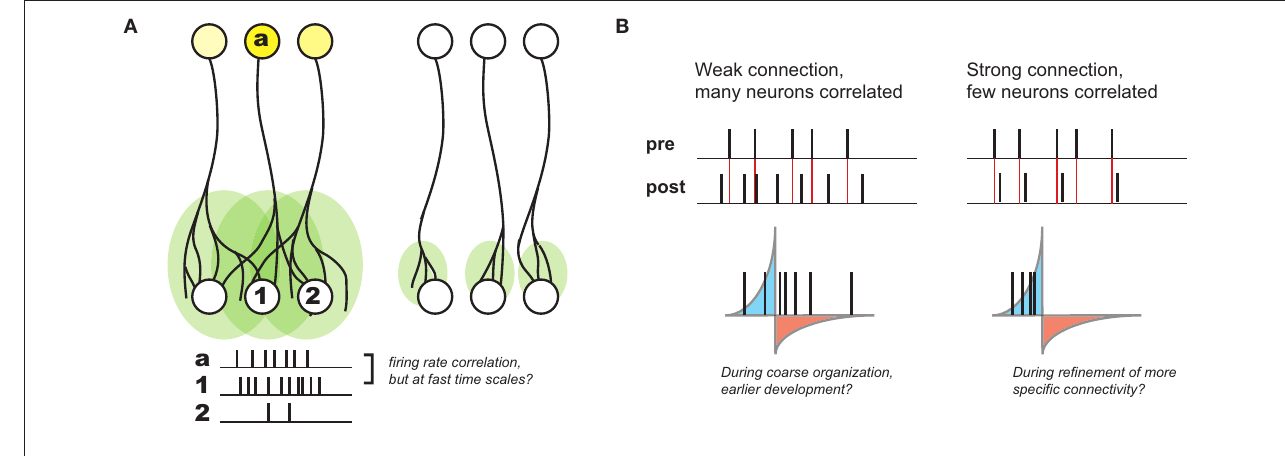
Figure 1 | Development of coarse patterning of CNS connections. (A) Projections between different brain regions often are initially larger and diffuse ( left ), but refine over time in an activity dependent manner ( right ). Because of initial organization of this map, local activity patterns generally drive the highest postsynaptic firing in the center of a given afferent (a) projection (compare activity of neuron #1 with #2). As a result, Hebbian principles generally can explain this